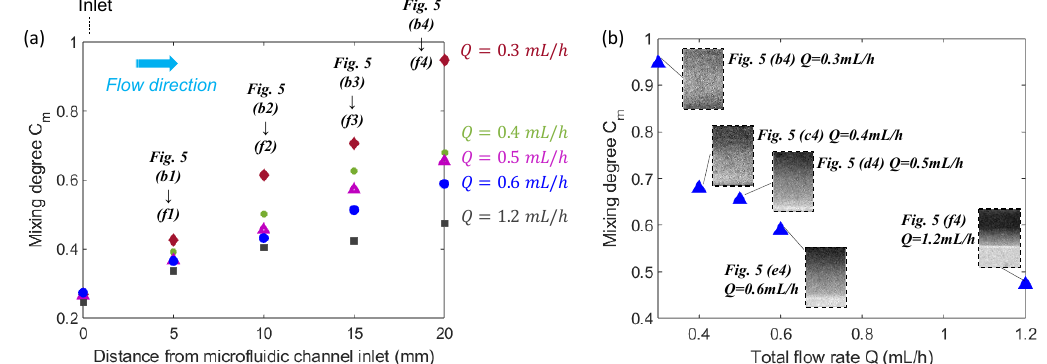
Figure 6. ( a ) The evolution of the mixing degree C m along flow direction for various total flow rate Q. The spots represent the mixing degree corresponding to the experimental images in Figure 5. ( b ) E ff ect of total flow rate Q on the mixing degree C m corresponding to the images from (b4)–(f4) in Figure 5. The concentration (v / v) of ferrofluid is 1.2% (v / v), the flow rate ratio between ferrofluid to water is 1:1, and the spots represent the mixing performance at the outlet (x = 20 mm) of fluidic channel in Figure 5 for various total flow